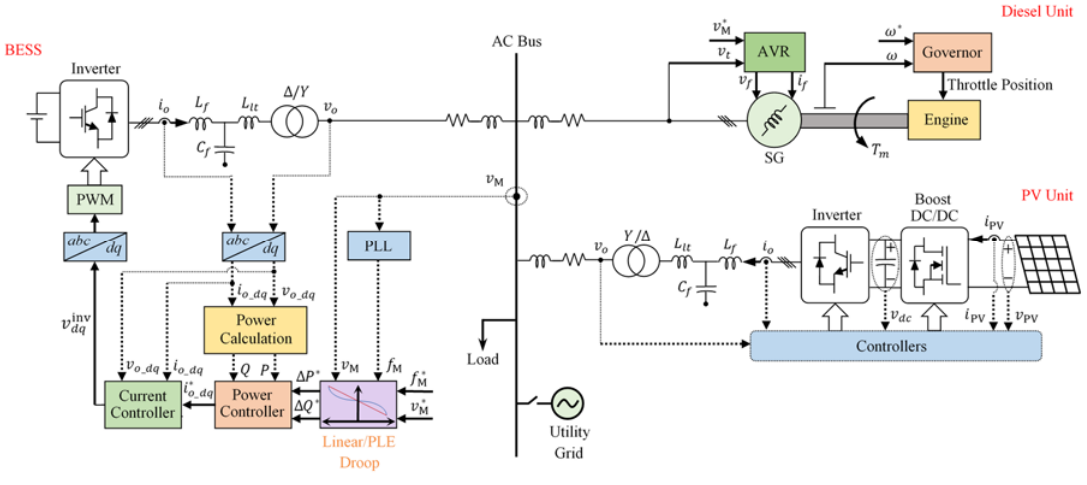
Figure 2. Schematic of the islanded mixed ‐ inertia microgrid under study.